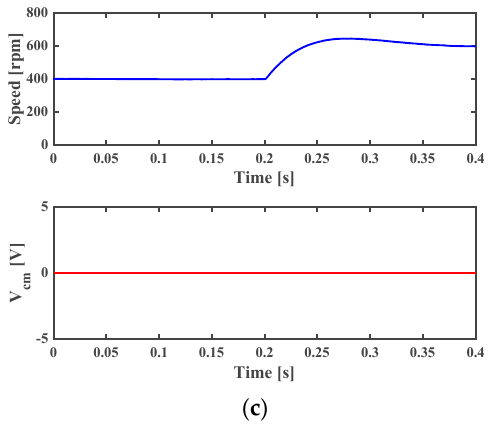
Figure 5. Simulation results for the torque and change in the speed. ( a ) Machine currents ( top ) and phase voltage ( bottom ); ( b ) dq -axis currents; ( c ) rotor speed ( top ) and common-mode voltage ( bottom ).